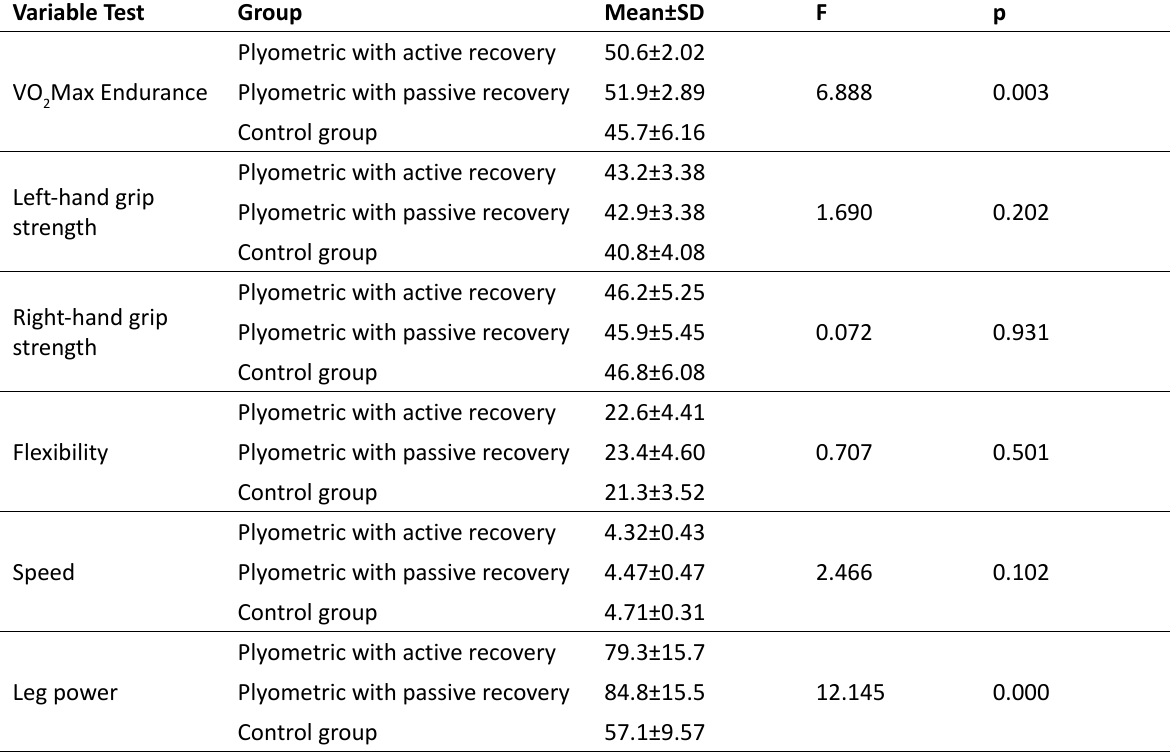
Table 3 . Parameters of difference in post-test results of the experimental group and control group Variable